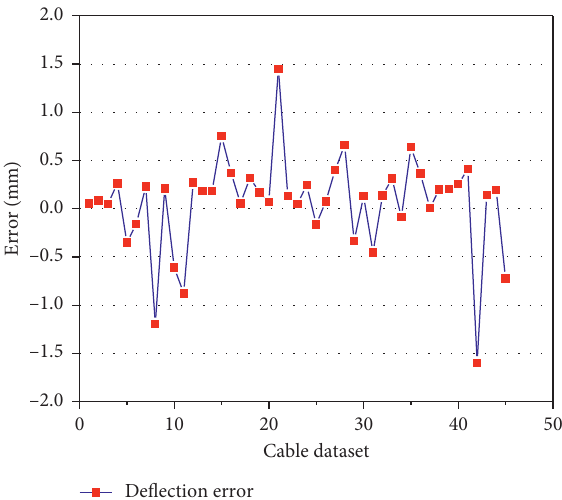
Figure 16: Distribution of maximum displacement error of nodes under the inner